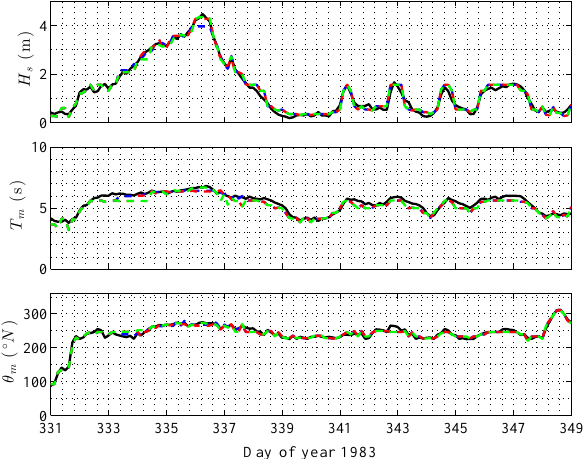
Figure 12. TSOM: comparison of original (black solid line) and resulting histograms representing the PDFs of H s (top panel), T m (central panel) and θ m (bottom panel), for the whole data set. Thresholds: 95th (blue dashed-squares line), 97th (red dashed- circles line) and 99th (green dashed line) percentile of H s